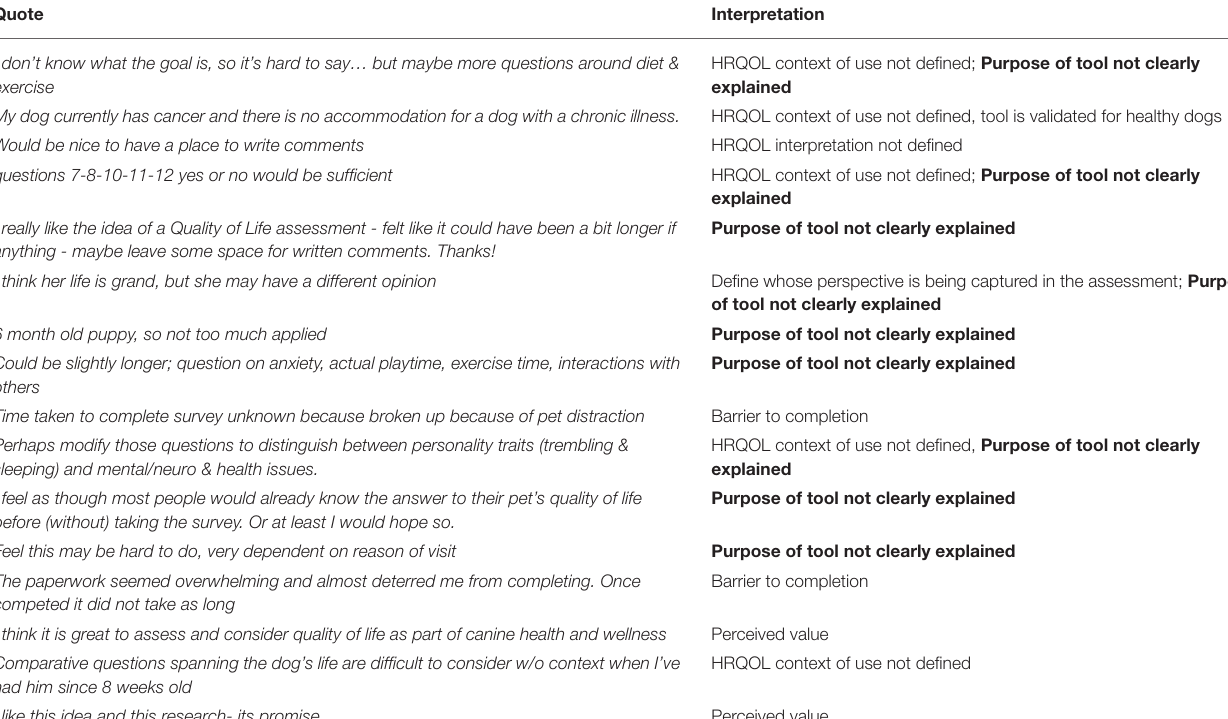
TABLE 1 | Phase 1 Client feedback and interpretation on Canine QOL